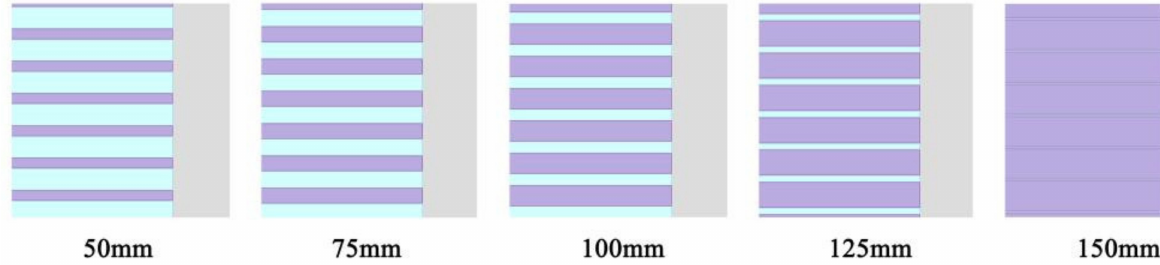
Figure 15. Louver size diagram.